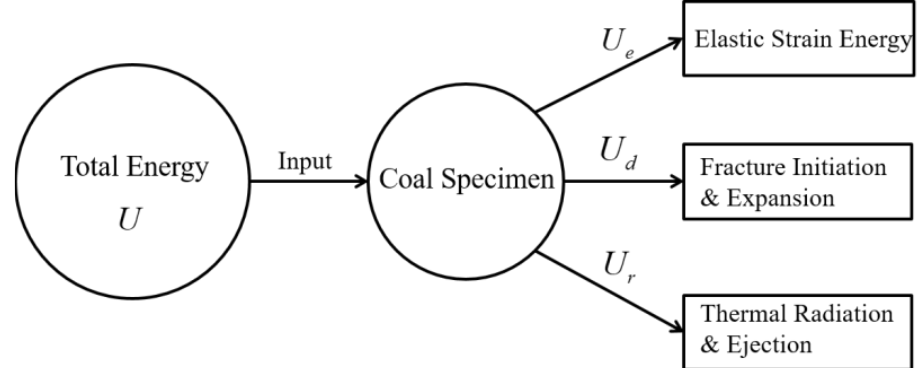
Figure 3. The energy conversion of coal specimen in the failure process.